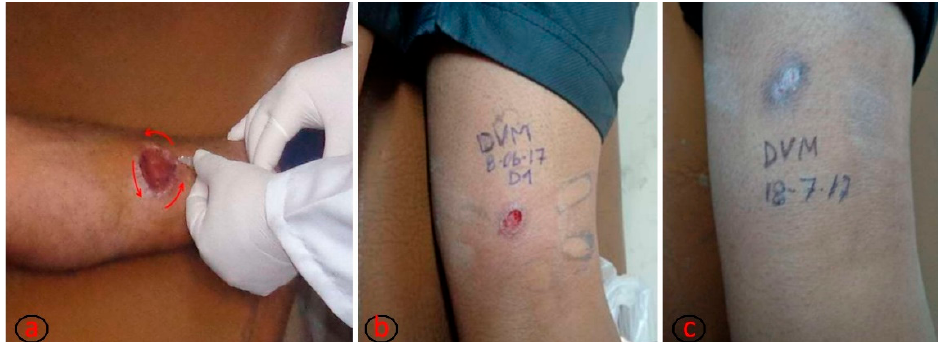
Figure 1. ( a ) Process of intralesional application of meglumine antimoniate on the ulcer borders until obtaining a whitened area around the ulcer. The total volume of drug to be applied for each ulcer is calculated by multiplying the ulcer area by the mathematical factor 0.008 [17]. ( b ) Ulcer before intralesional treatment. ( c ) Ulcer healed, corresponding to the first month after treatment conclusion. Pictures b and c are from the same patient. The photographs are property of Ernesto Rojas Cabrera